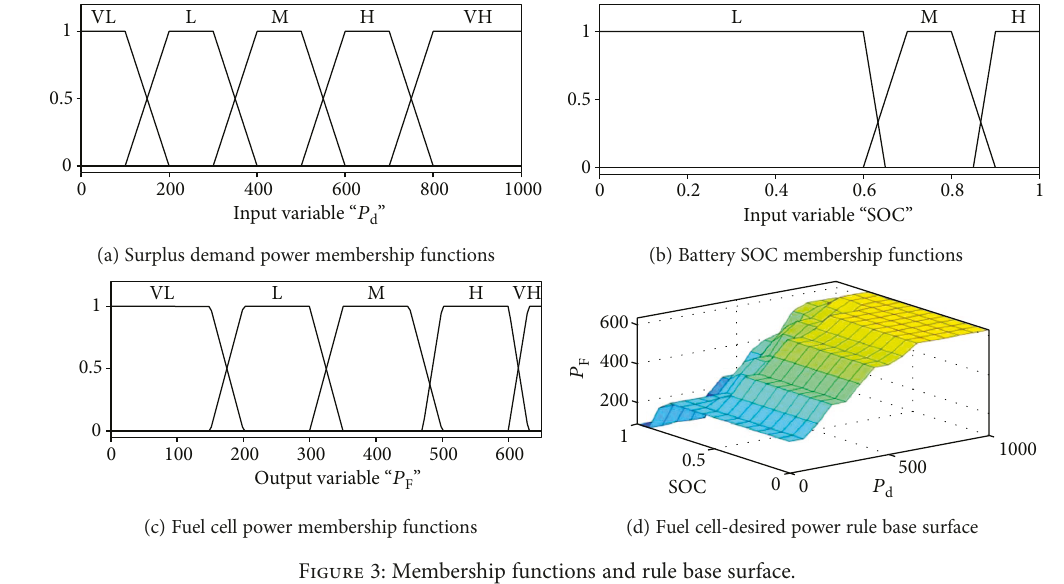
Figure 3: Membership functions and rule base surface.